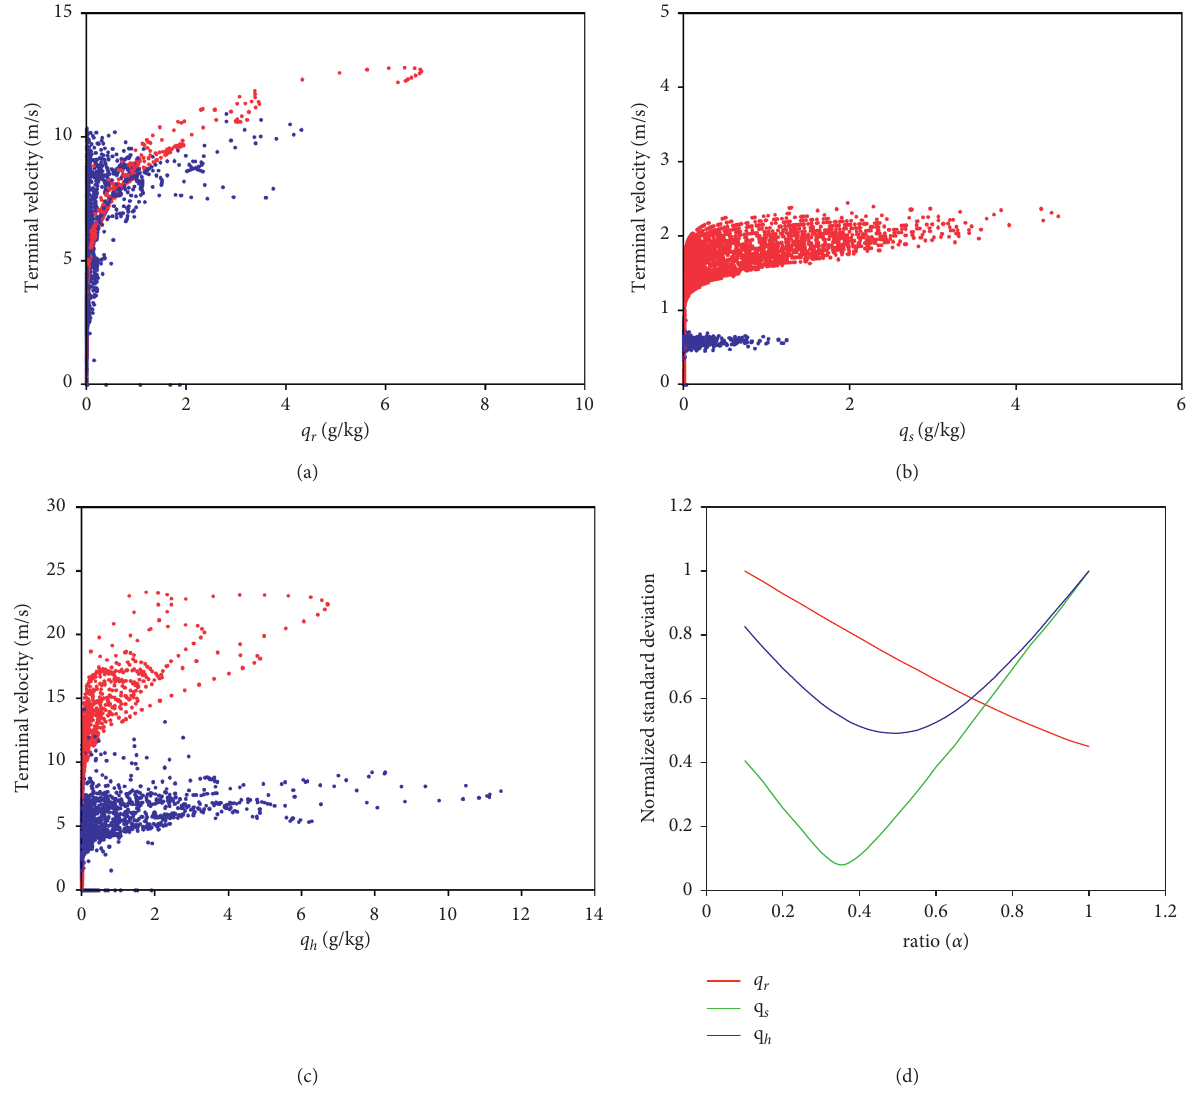
Figure 4: Terminal velocity distributions with respect to (a) q � 2h for all model levels. Terminal velocities yielded by r , (b) q s , and (c) q h at T LINref are shown with red dots and those of MY2ref are blue. The normalized standard deviations between the terminal velocity frequencies of LINref and MY2ref are shown in (d) for rain (red), snow (green), and hail